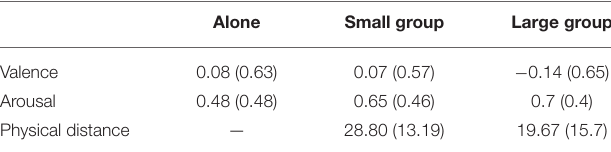
TABLE 5 | Mean (SD) of the normalized ratings ( z -scores) of valence and arousal, and of the ratings of physical distance across the three categories of images (alone, small group and large